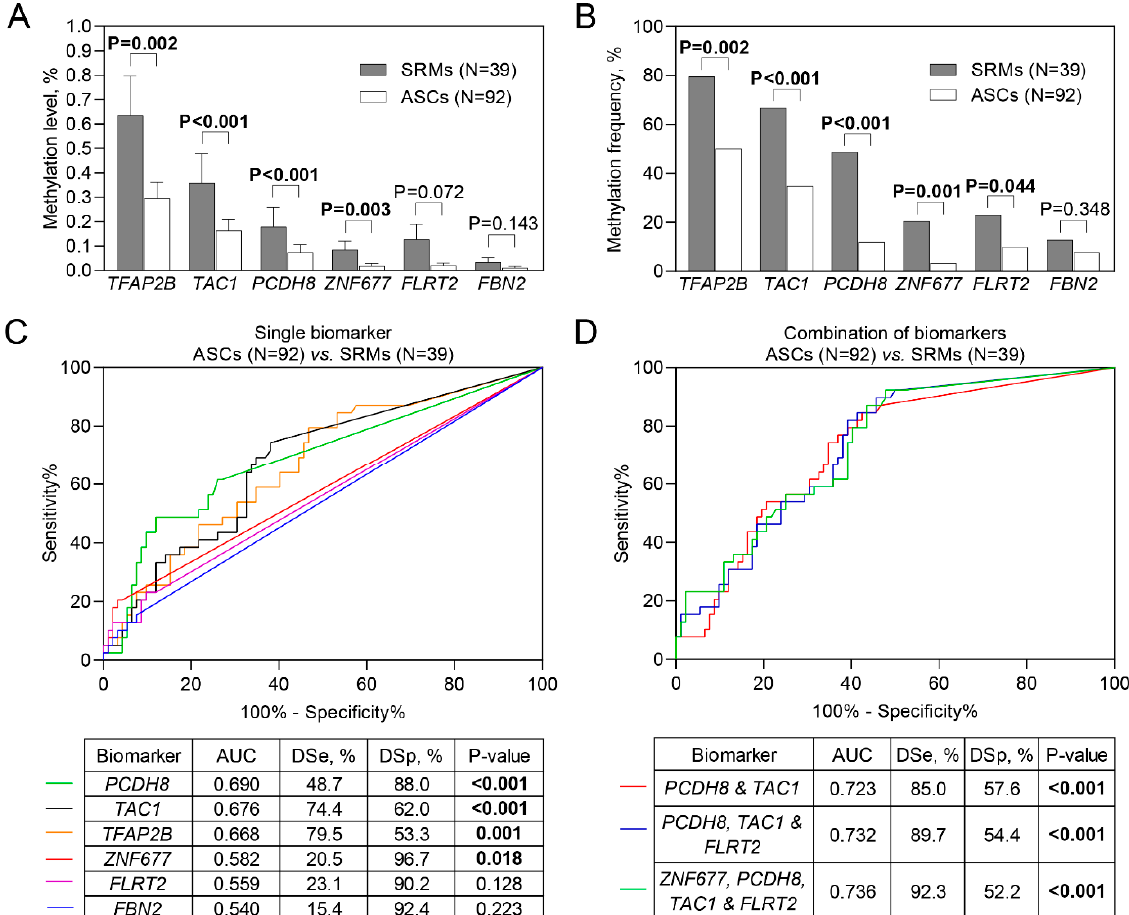
Figure 2. Diagnostic characteristics of the investigated biomarkers. ( A ) Methylation levels of TFAP2B , TAC1, PCDH8 , ZNF677 , FLRT2, and FBN2 in the urine samples from patients diagnosed with small renal masses (SRMs; pT1a; ≤ 4 cm) and asymptomatic controls (ASC). ( B ) Frequencies of methylated TFAP2B , TAC1 , PCDH8 , ZNF677 , FLRT2, and FBN2 among the patients diagnosed with SRMs and ASCs. ( C ) ROC curve analysis for single biomarkers. ( D ) The combination of biomarkers in distinguishing patients with SRMs and ASC. The bars represent the average DNA methylation levels with a standard error of the mean. ROC—receiver operating characteristic; AUC—area under the curve; DSe—diagnostic sensitivity; DSp—diagnostic specificity. Significant p values are in bold.